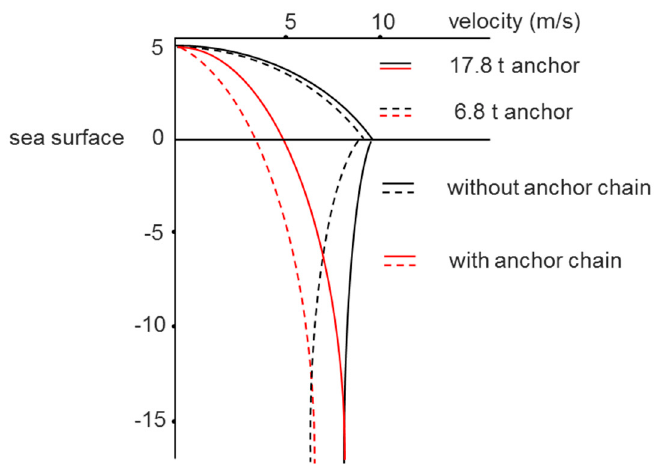
Figure 1. Falling speed of an anchor with and without a chain .